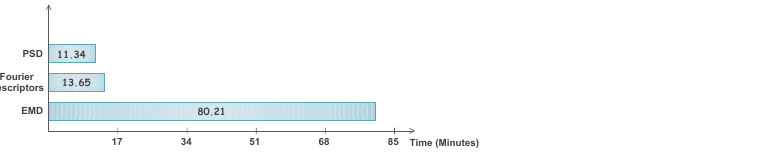
Figure 11. Classification time of three feature sets using proposed technique in